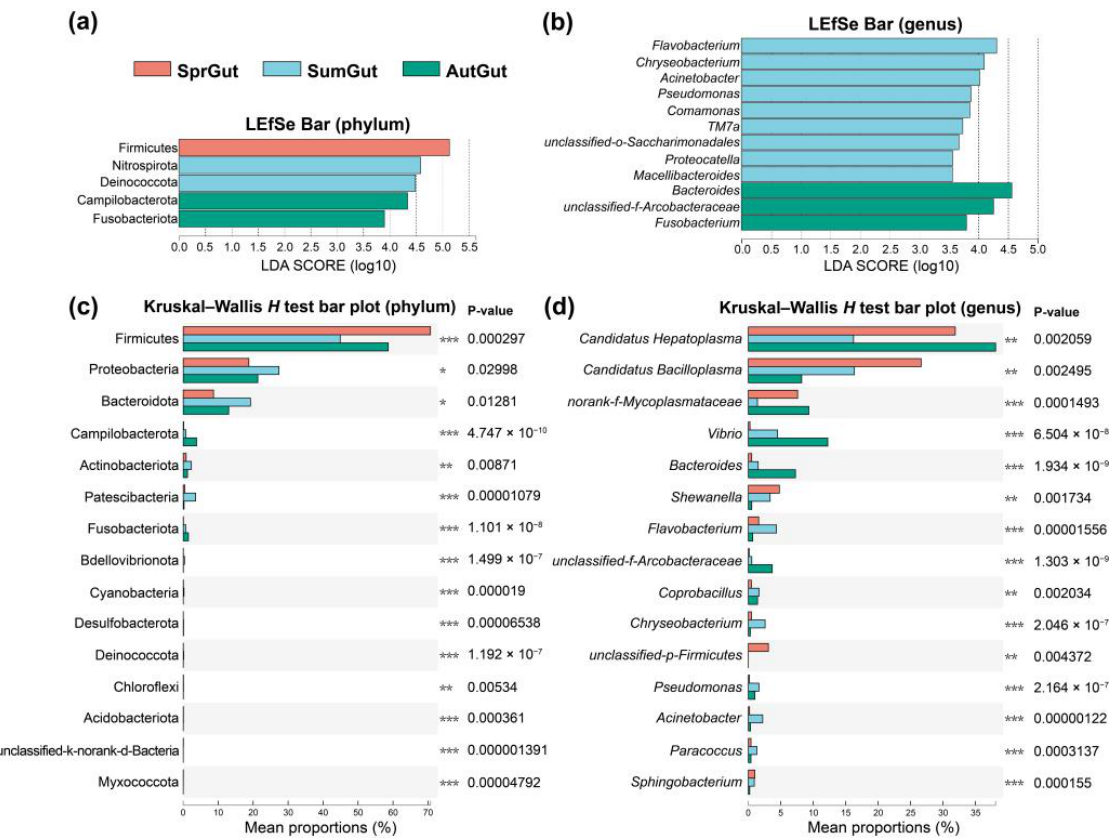
Figure 6. LEfSe analysis of Sinopotamon planum gut microbiota at the phylum ( a ) and genus ( b ) level, and comparison of gut microbiota composition abundances of S. planum at the phylum ( c ) and genus ( d ) level in the studied seasons. Significant differences were marked as “*” ( p < 0.05), “**” ( p < 0.01), and “***” ( p < 0.001).